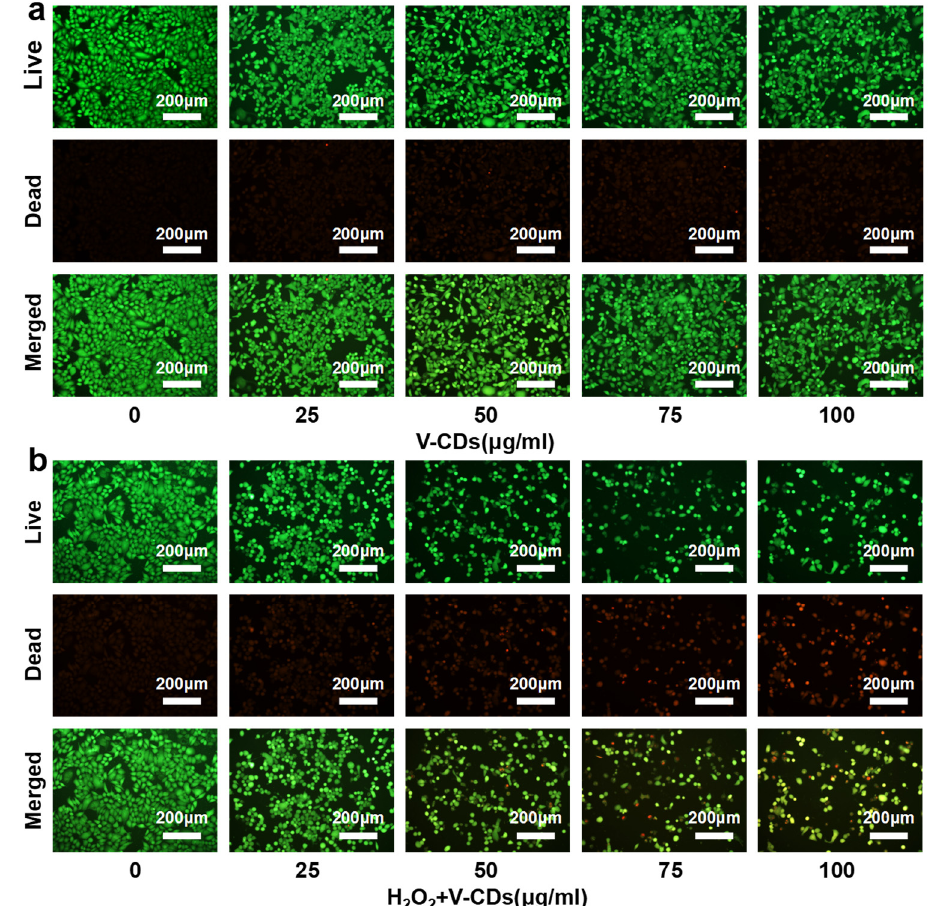
Figure 6. Live/dead staining of HeLa cells ( a ) HeLa cell treated with different concentrations V − CDs. Control was cells not treated with V − CDs. and ( b ) HeLa cell treated with different concentrations V − CDs in the presence of H 2 O 2 . Control was cells not treated with V − CDs. Scale bar represents 200 µ m.